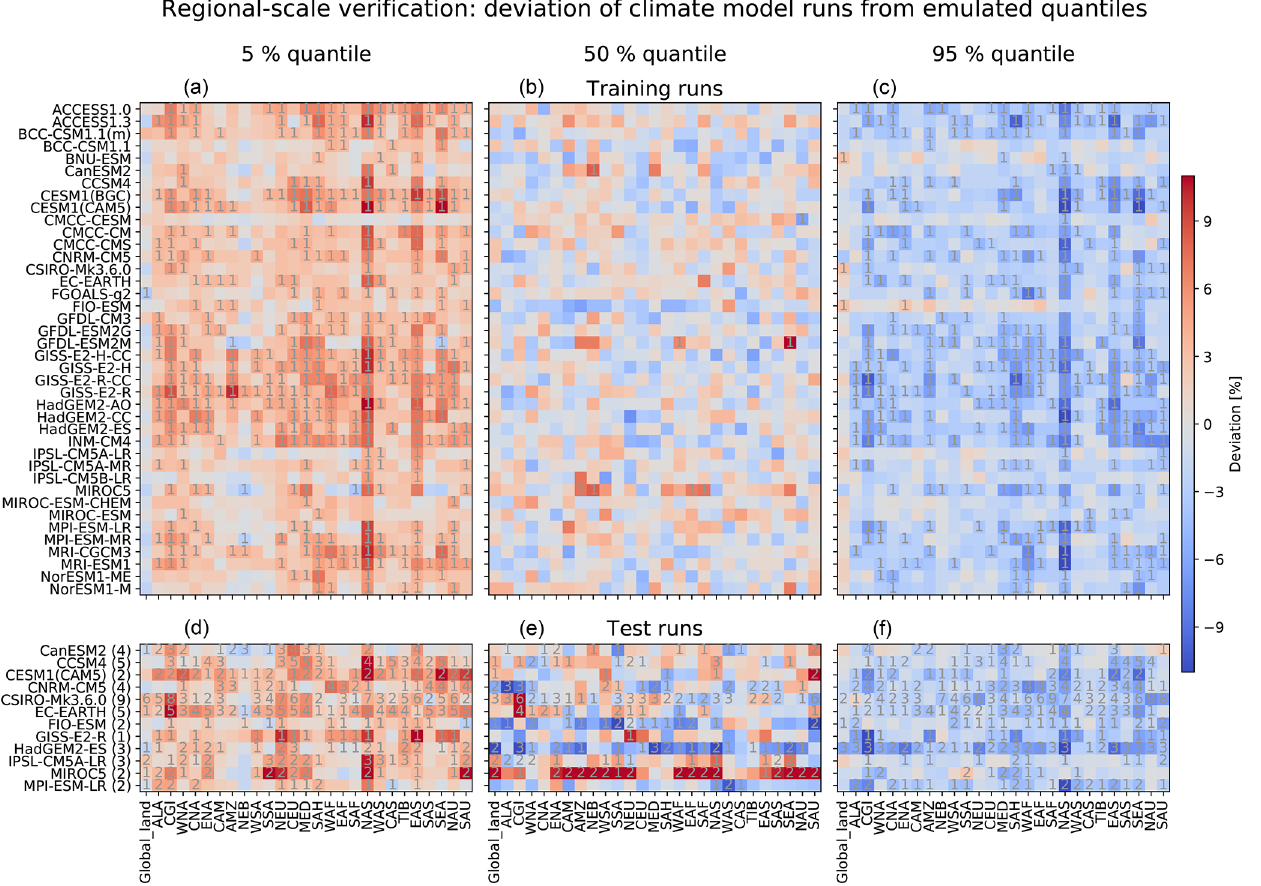
Figure 12. Deviation of climate model runs from the emulated 5% (a, d) , 50% (b, e) , and 95% (c, f) quantile for CMIP5 models (rows) and regions (columns). The emulated quantile is computed based on 1000 emulations per climate model. The deviation of the climate model run from the emulated quantile is given in color. Red means that the emulated quantile is warmer than the quantile of the climate model run, and blue means that it is colder. The gray numbers indicate how many climate model run deviations lie outside the 95% interval spanned by the deviations of single emulations from the emulated quantiles. If the climate model run lies outside this interval, it is no longer considered indistinguishable from the emulations. The deviation from the training run is shown in panels (a) – (c) , and the average deviation across all available test runs is shown in panels (d) – (f) . The number of test runs averaged across is indicated in brackets behind the model